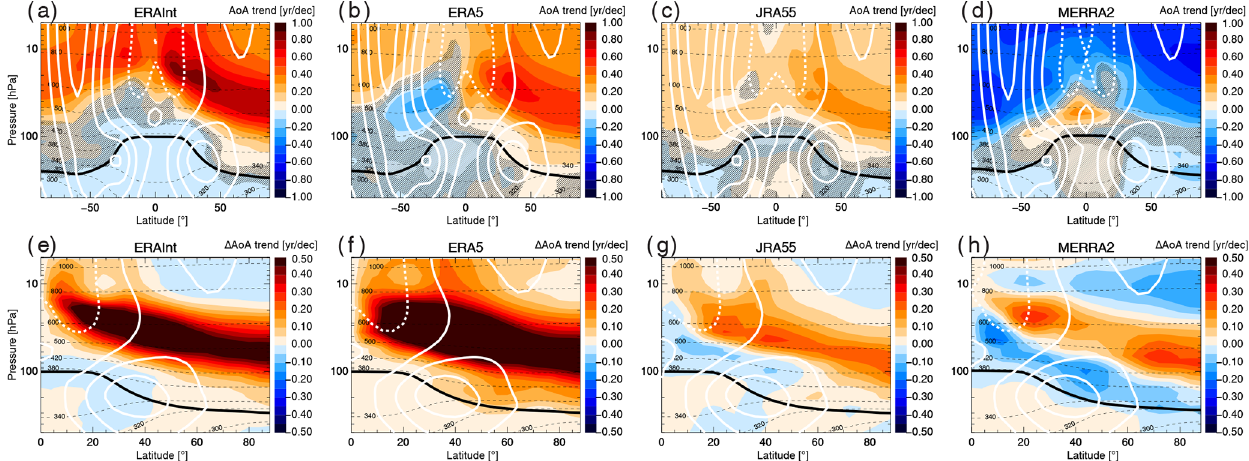
Figure 1. (a–d) Mean age trends for the period 2005–2017 for ERA5, ERA-Interim, JRA-55 and MERRA-2. (e–h) Hemispheric difference in mean age trends (NH minus SH) for different reanalyses for the period 2005–2017. White lines show zonal wind contours (solid for positive, dashed for negative values; ± 10ms − 1 steps), thin dashed black lines potential temperature levels and the thick black line the WMO tropopause. Regions where trends are not significant are hatched (i.e. where trend values are below 2 σ , with σ being the standard error of the linear